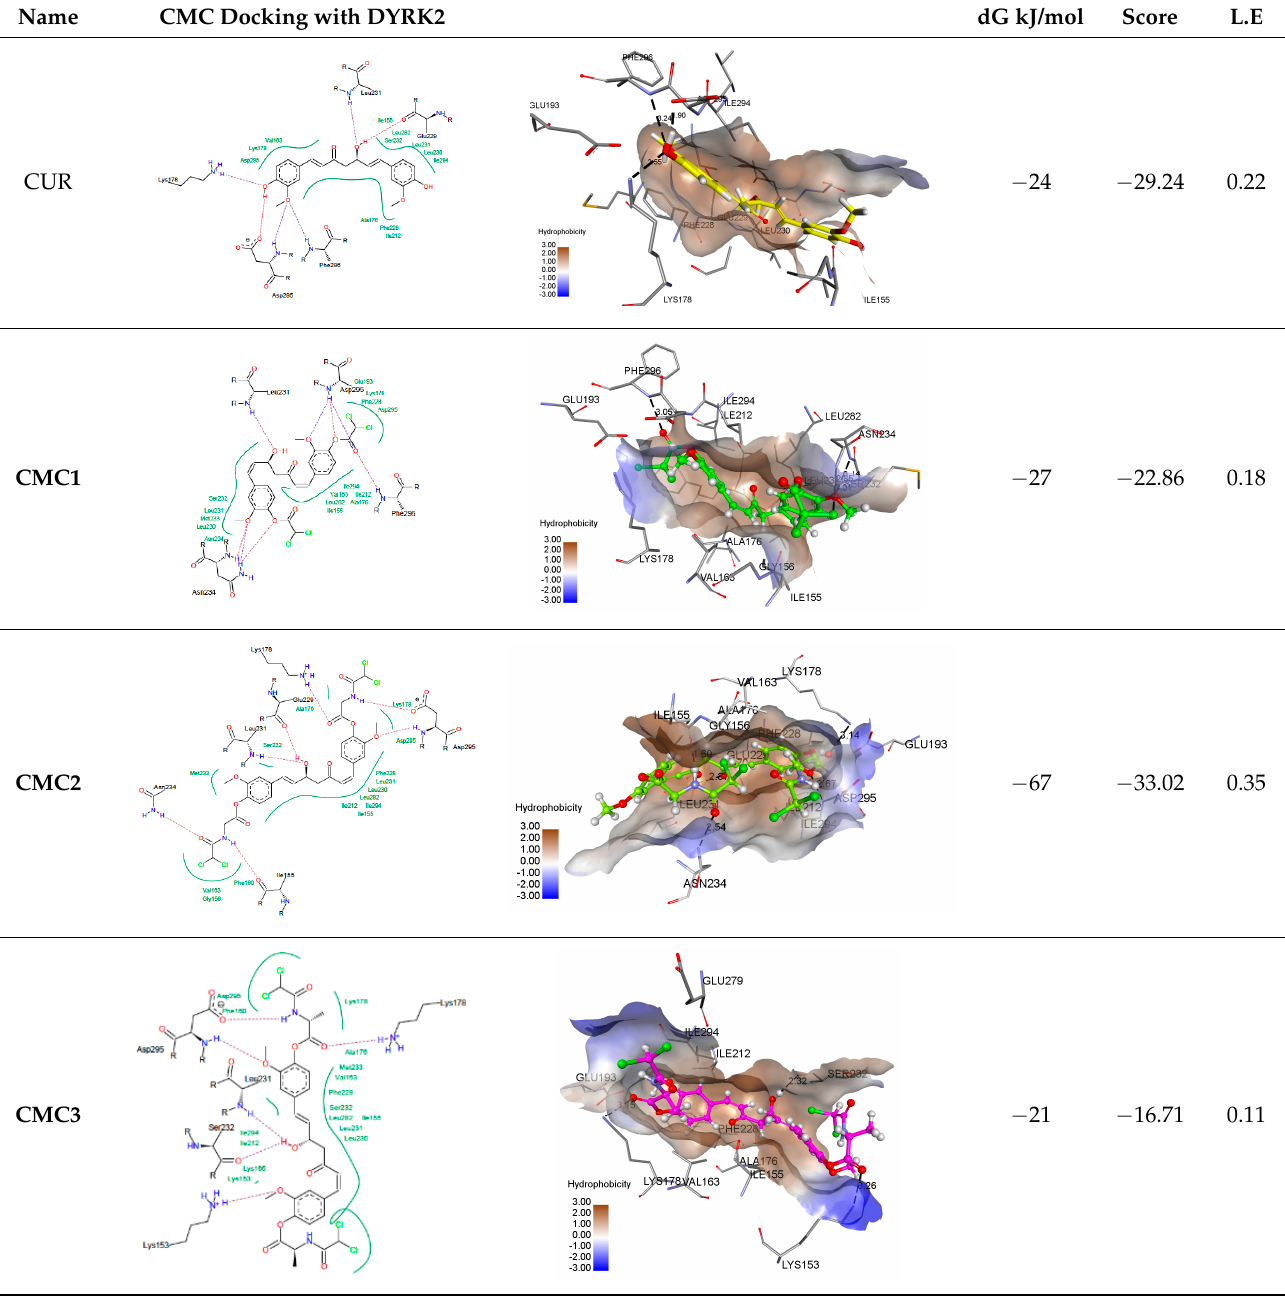
Table 2. Molecular docking and predicted ADME properties of CMC compounds.